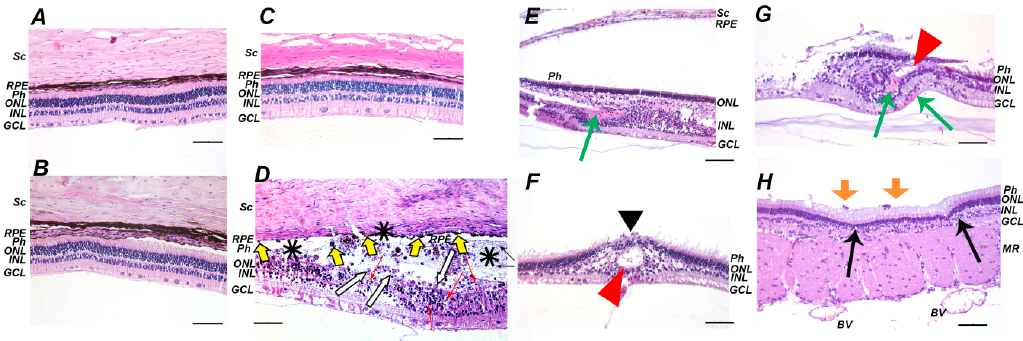
Figure 2. Histopathological findings in rabbit retina after the illumination with intense visible light (30,000 lx, 3 h). ( A )–( C ): before ( A ), immediately after ( B ) and one day after ( C ) the illumination retina demonstrates intact morphology. ( D ): acute signs of the retinal damage three days after the illumination. The signs include the presence of pycnotic nuclei and apoptotic bodies of photoreceptors (red arrows), retinal detachment from retinal pigment epithelium (RPE) (asterisks), activation of RPE cells (yellow arrows). ( E )–( H ): delayed signs of the retinal damage seven days after illumination. The signs include thinning of outer nuclear layer (ONL) and inner nuclear layer (INL) ( E ) and gliosis ( E , green arrow), total loss of photoreceptors ( F , black arrowhead), glial scar formation, and newly formed canals filled with edematous fluid ( F , red arrowhead), Muller glia activation and hypertrophy and eosinophilic areas ( G , green arrows), areas of ONL thinning ( H , black arrows) and inflammatory cells between photoreceptor layer and RPE ( H , orange arrows). Representative cross-sections of ocular fundus staining with hematoxylin and eosin; magnification 200×. Scale bar 20 μ m. Retinal detachment at B and E is of artificial origin. Abbreviations: BV, blood vessel; GCL, ganglion cell layer; INL, inner nuclear retinal layer; MR, medullary ray; ONL, outer nuclear retinal layer; Ph, photoreceptor layer; RPE, retinal pigment epithelium; Sc, sclera.